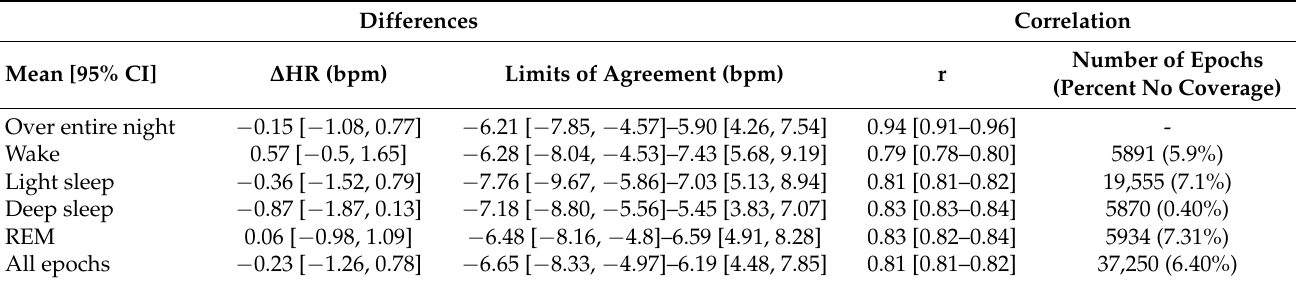
Table A2. Summary of correlation and Bland–Altman metrics for HR for all participants. The number of epochs refers to epochs that were included in the analysis of each group. No coverage refers to the percentages of epochs for which the smart bed did not produce a HR reading, but a PSG HR reading was available. A positive (or negative) bias indicated that the smart bed underestimated (or overestimated) the PSG-derived measure.